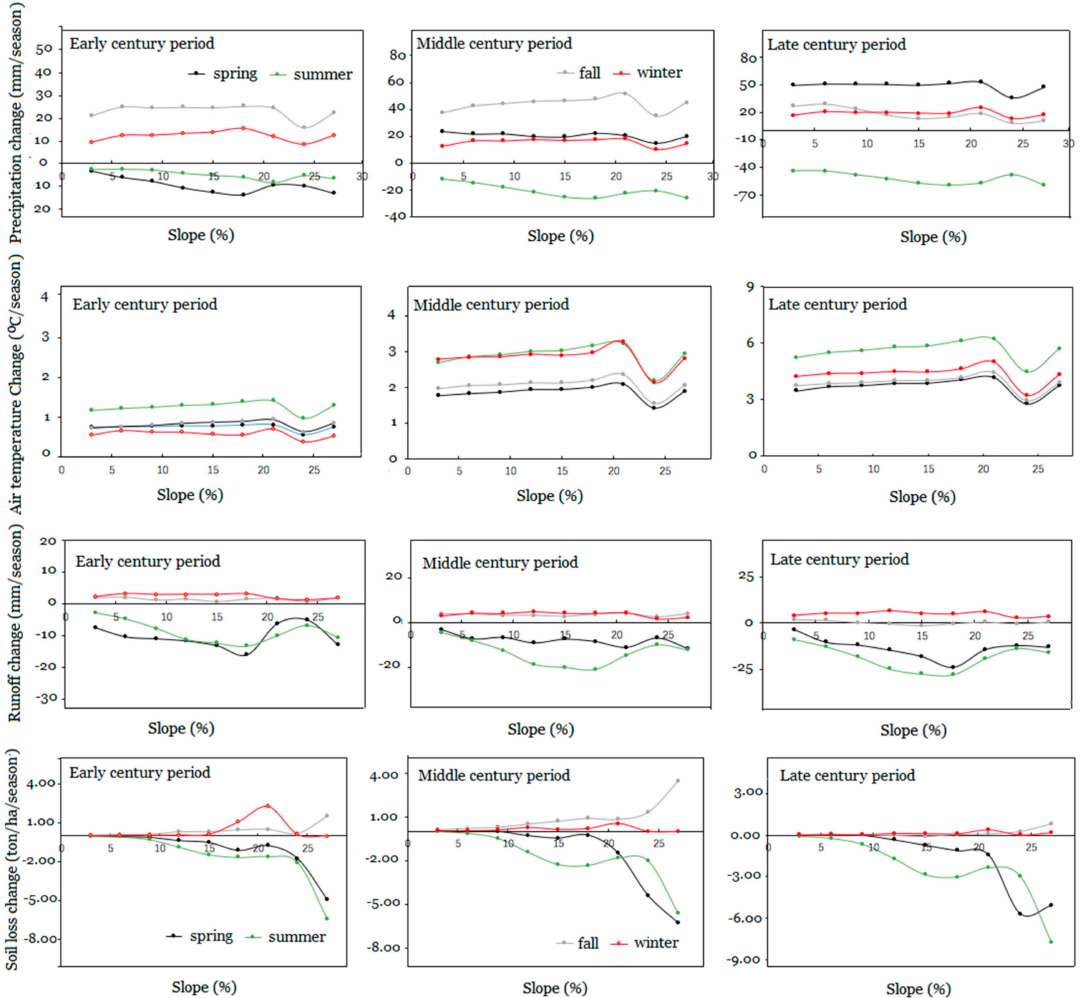
Figure 7. Seasonal changes of precipitation, air temperature, runoff, and soil loss with slope gradients in cropland under the A2